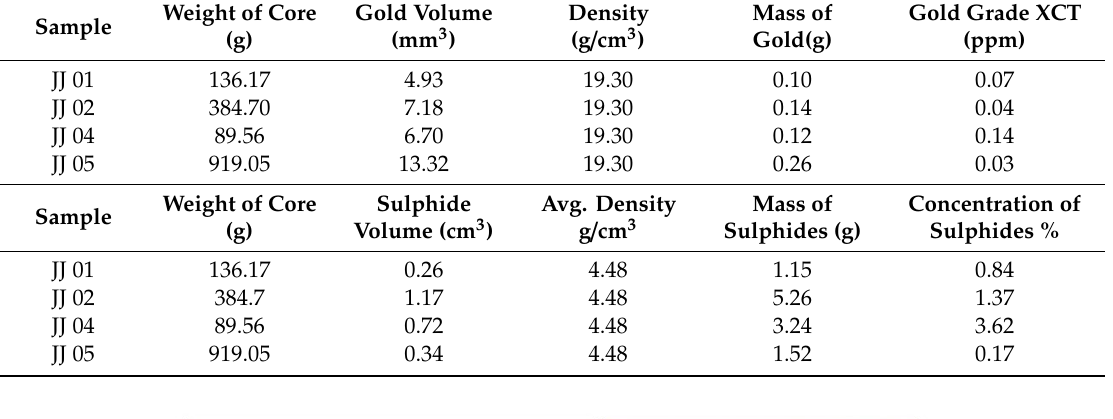
Minerals 2019 , 9 , x FOR PEER REVIEW minerals bright pixels in red circle depicts garnet porphyroblasts identified as small round white dots. ( c ) Thin section made from the core proving the presence of garnet. ( d ) Backscattered gold elemental map obtained from the SEM analysis of the 2D cut surface of the core. The bright spots represent the spots where gold was found. Gold grains are small in SEM due to partial volume effect. Sample JJ01 and JJ02. Table 2. Distribution of gold and sulphides in analysed drill core samples. Average density of sulphides was calculated by averaging the densities of individual sulphides identified in 2D microscopy.